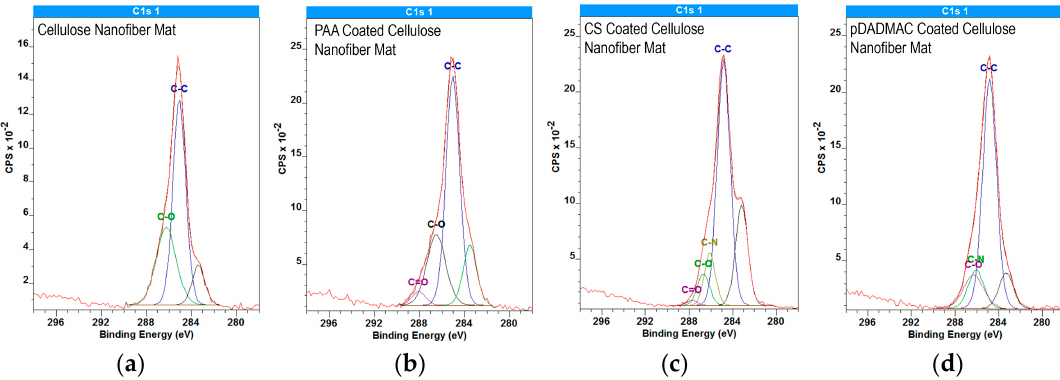
Figure 3. High-resolution C1s XPS spectra for ( a ) cellulose nanofiber mats; ( b ) PAA; ( c ) CS; and ( d ) pDADMAC-functionalized cellulose nanofiber mats. The individual contributions to the data from different functional groups such as C-C (285.0 eV), C-O (286.6 eV), and C-N (286.1 eV), and C=O (287.9 eV) are provided. The unmarked curve at 283 eV is likely due to the morphologically heterogeneous nature of the nanofiber mats. XPS data was acquired on N = 2 nanofiber mats, which were scanned at three unique locations per sample.